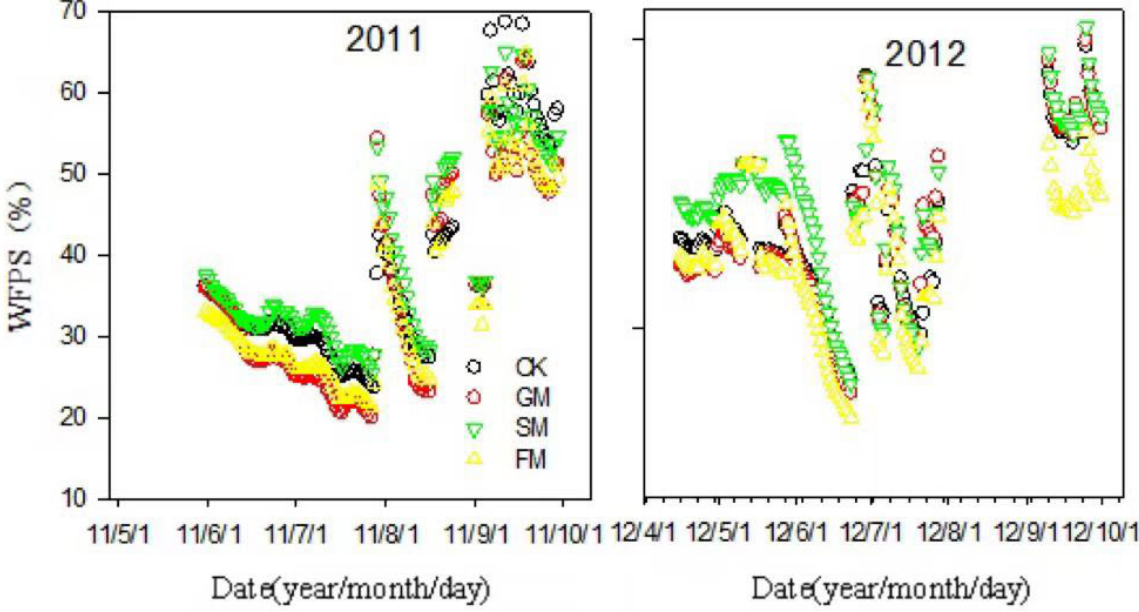
Figure 2. Soil water-filled pore space (WFPS) under the different mulching treatments in the top 20 cm of soil.